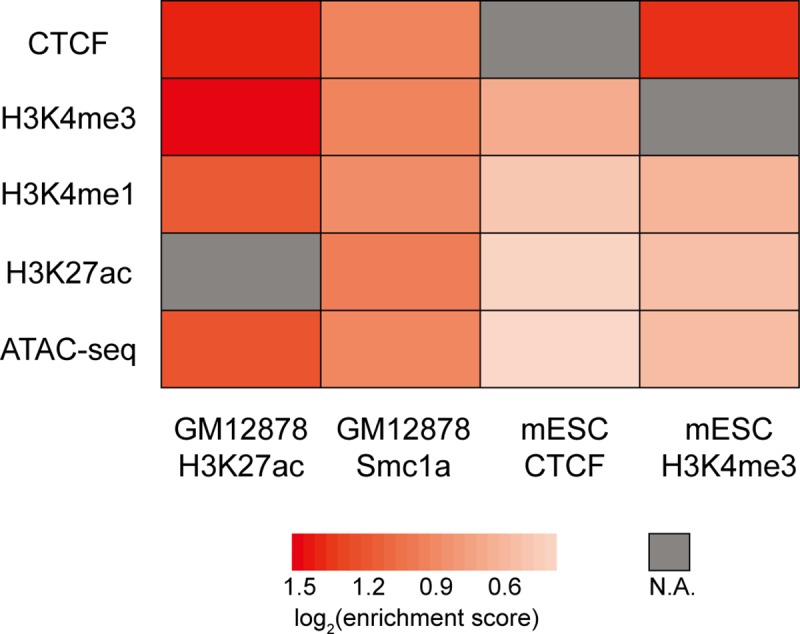
Cis-regulatory elements are enriched in the target bins of MAPS-identified “XOR” interactions.As only interactions from the “XOR” set are considered, CTCF enrichment analysis is not applicable for mESC CTCF PLAC-seq data, H3K4me3 enrichment analysis is not applicable for mESC H3K4me3 PLAC-seq data, and H3K27ac enrichment analysis is not applicable for GM12878 H3K27ac HiChIP data (denoted as N.A. in the heatmap). For each ChIP-seq/ATAC-seq data, we calculated the proportion of target bins and control bins containing ChIP-seq/ATAC-seq peaks, defined as %target and %control, respectively. We further defined the enrichment score as the ratio between %target and %control (numbers in S9 Table).